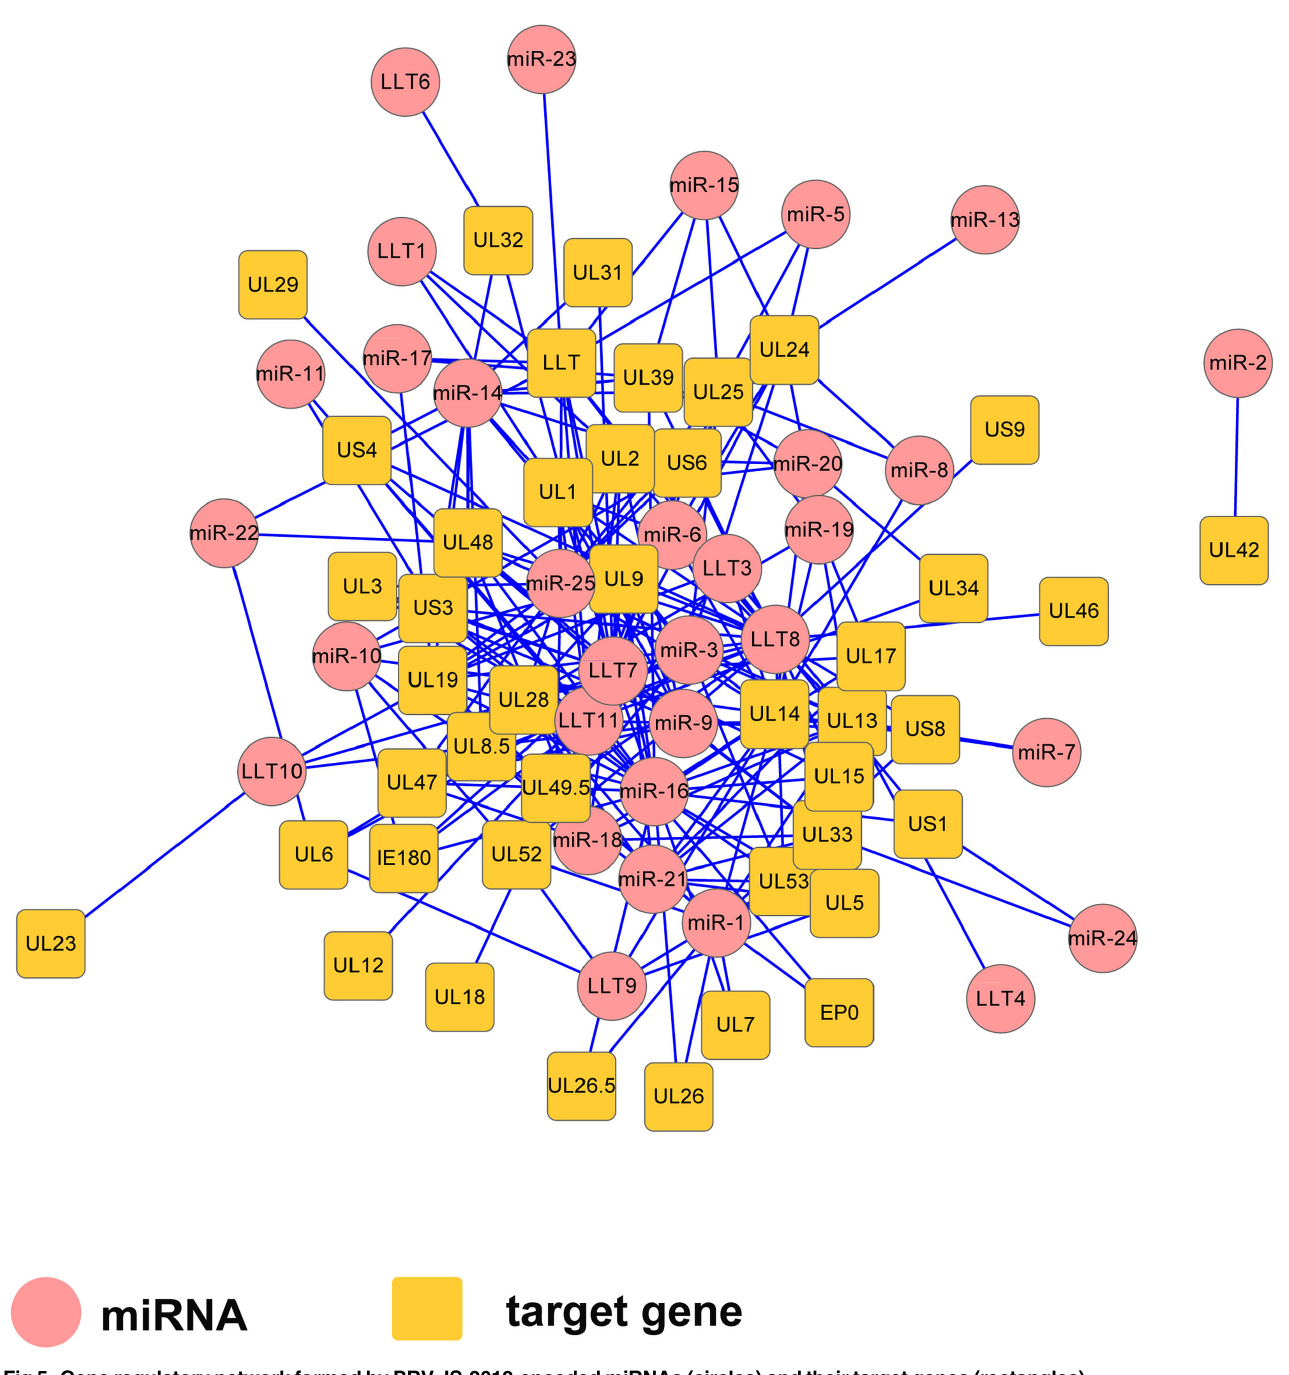
Fig 5. Gene regulatory network formed by PRV JS-2012-encoded miRNAs (circles) and their target genes (rectangles).